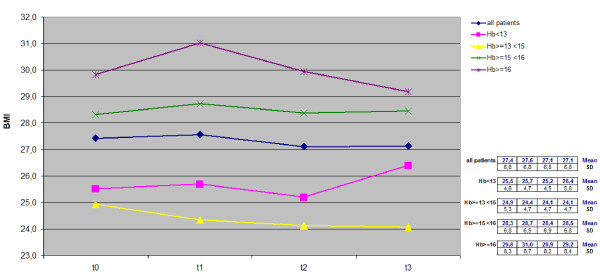
Time course of BMI values in the whole cohort and in each subgroup. BMI, body mass index; Hb, haemoglobin.